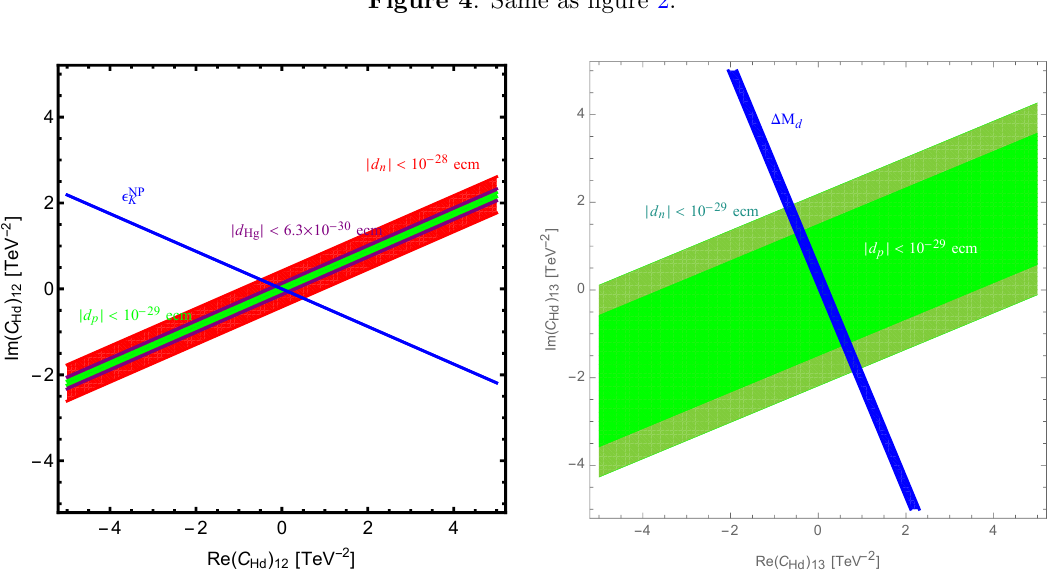
Figure 4 . Same as (cid:12)gure 2.